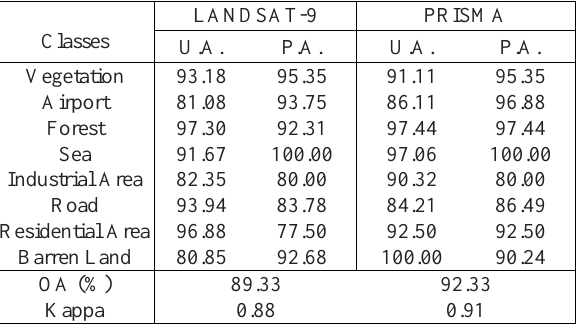
Table 5. The results of the accuracy assessment